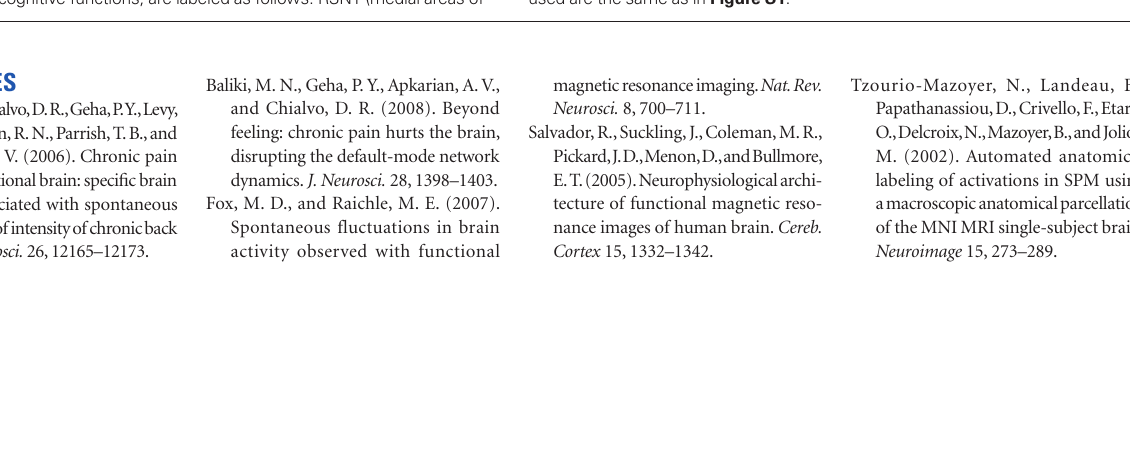
the visual cortex), RSN2 (lateral areas of the visual cortex), RSN3 (auditory), RSN4 (sensory motor), RSN5 (default mode network), RSN6 (executive control), RSN7 (right dorsal visual stream), RSN8 (left dorsal visual stream). Coordinates used are the same as in Figure S1